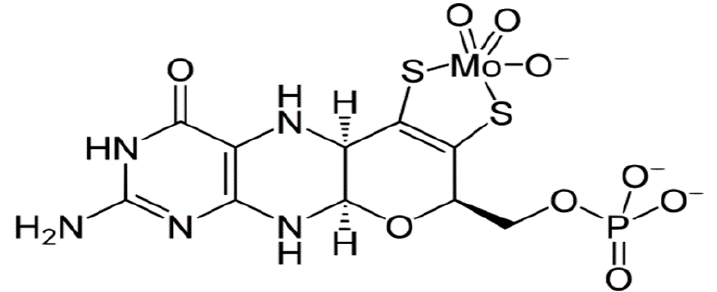
Figure 1. Mo co-factor—Moco.